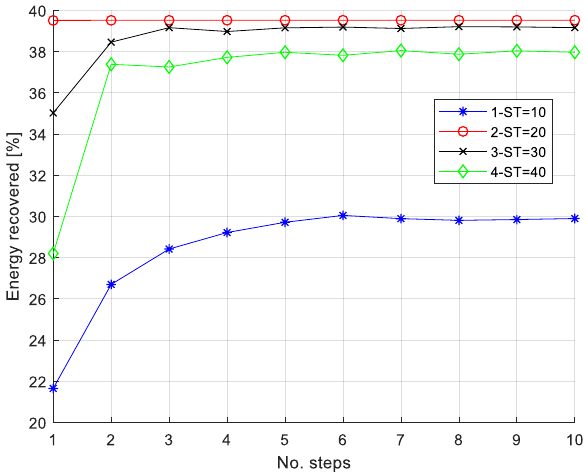
Figure 10. Fraction of energy recovered, starting at 75 km/h for stopping times from 10 to 40 s.